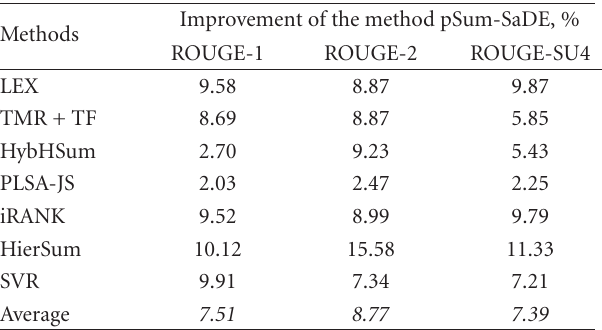
Table 2: Comparison pSum-SaDE with other methods. Methods